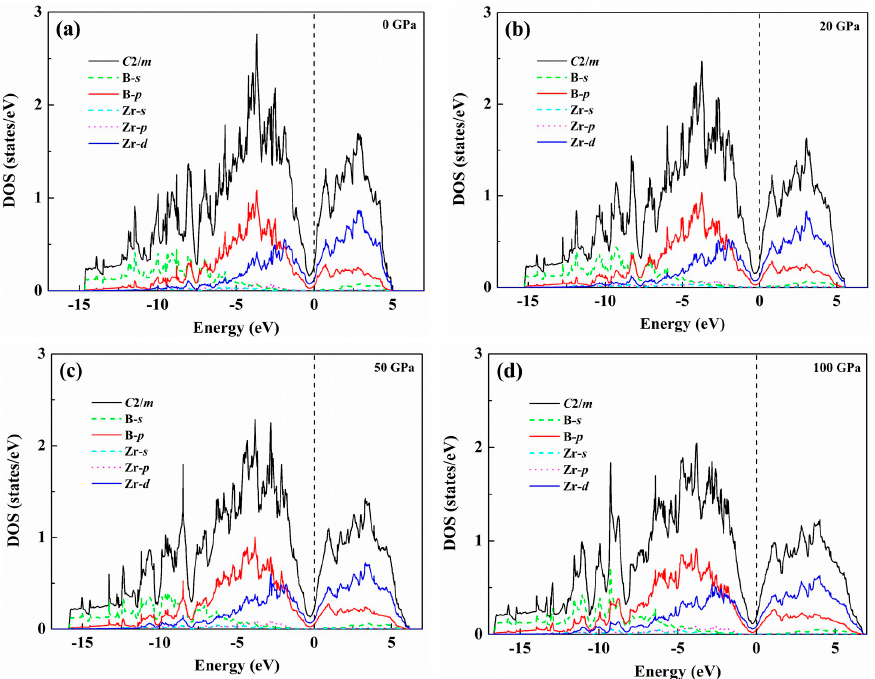
Figure 7. Total and partial density of states of the C 2/ m -ZrB 3 : ( a ) 0 GPa; ( b ) 20 GPa; ( c ) 50 GPa; and ( d ) 100 GPa. The vertical dashed line denotes the Fermi level E F .